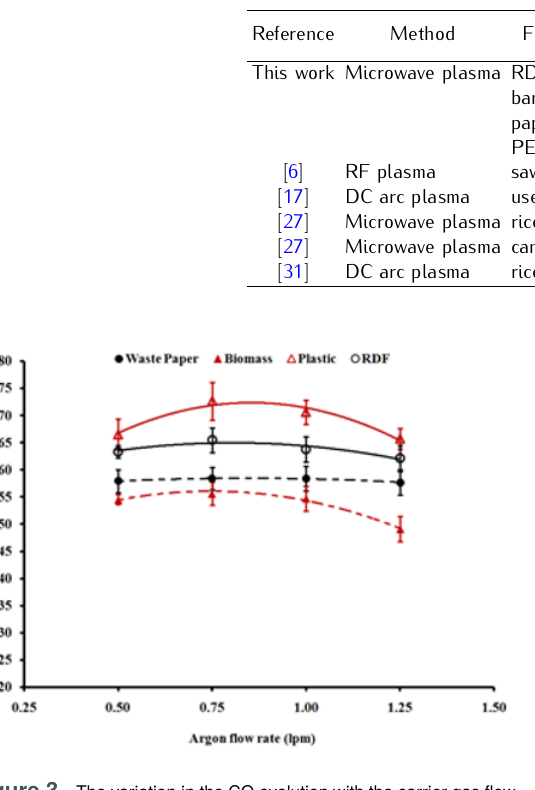
Table 5. Char from Plasma-assisted Pyrolysis Process